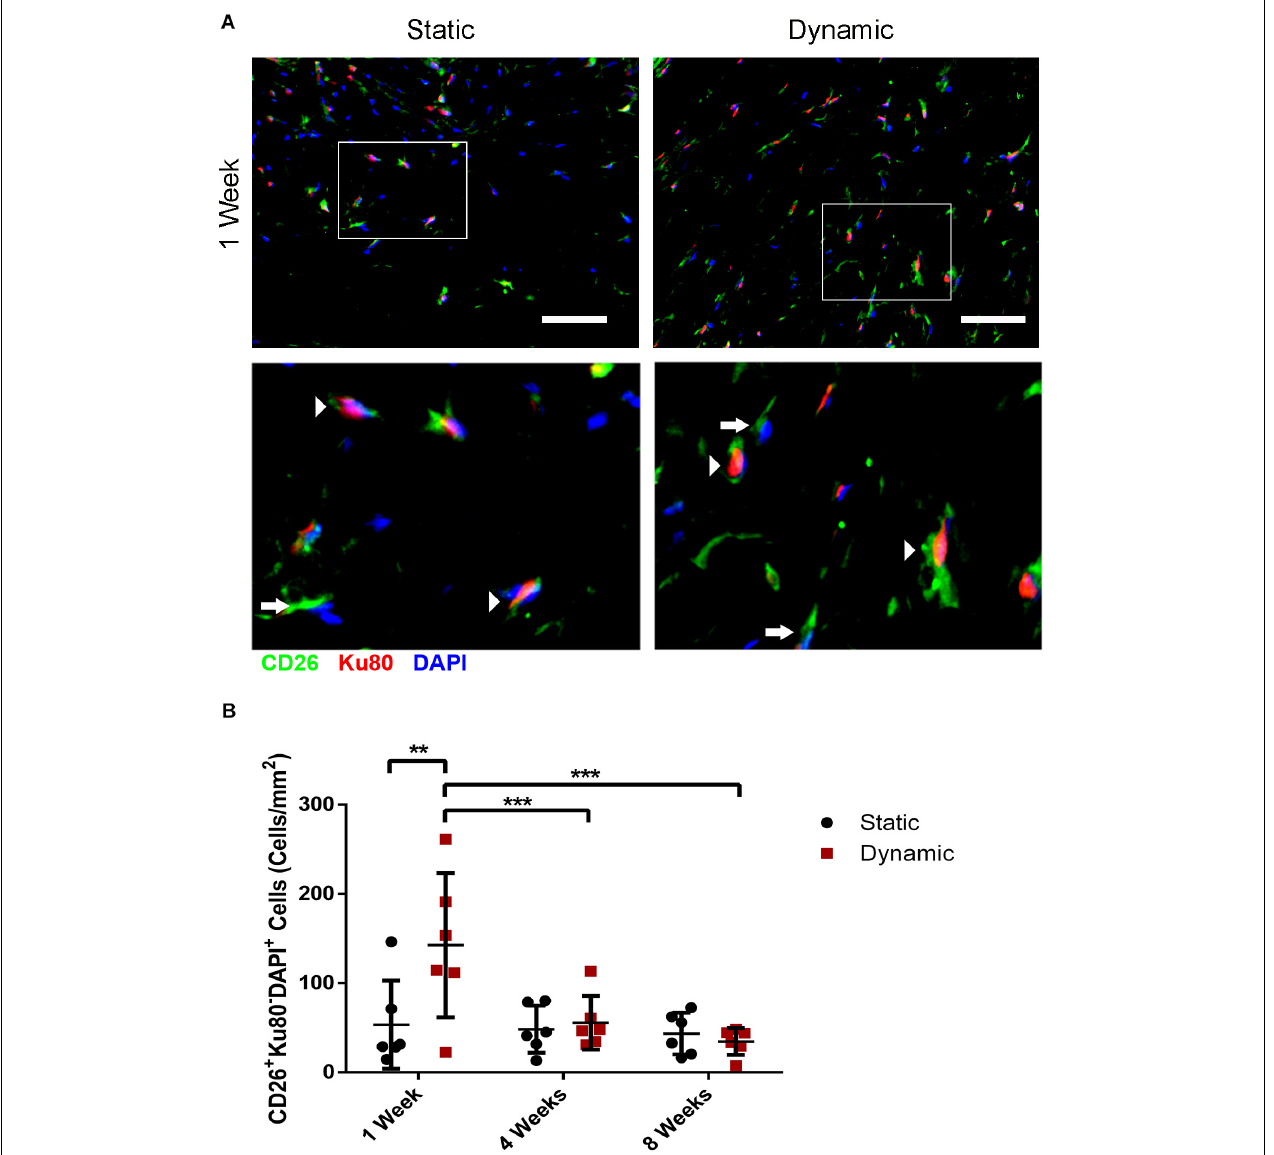
FIGURE 5 | Dynamic culture of human ASCs on the DAT scaffolds enhanced the recruitment of CD26 + host cells at 1-week post-implantation in the nu/nu mouse model. (A) Representative immunostaining of CD26 (green) in combination with human-specific Ku80 (red), with DAPI counterstaining (blue) at 1-week post-implantation. Scale bars represent 50 µ m. Boxed regions are shown at higher magnification below. Arrows indicate CD26 + Ku80 - DAPI + mouse cells and arrowheads highlight CD26 + Ku80 + DAPI + human cells. (B) CD26 + host cell (CD26 + Ku80 - DAPI + ) density within the DAT implants at 1, 4, and 8 weeks. ** p < 0.01, *** p <